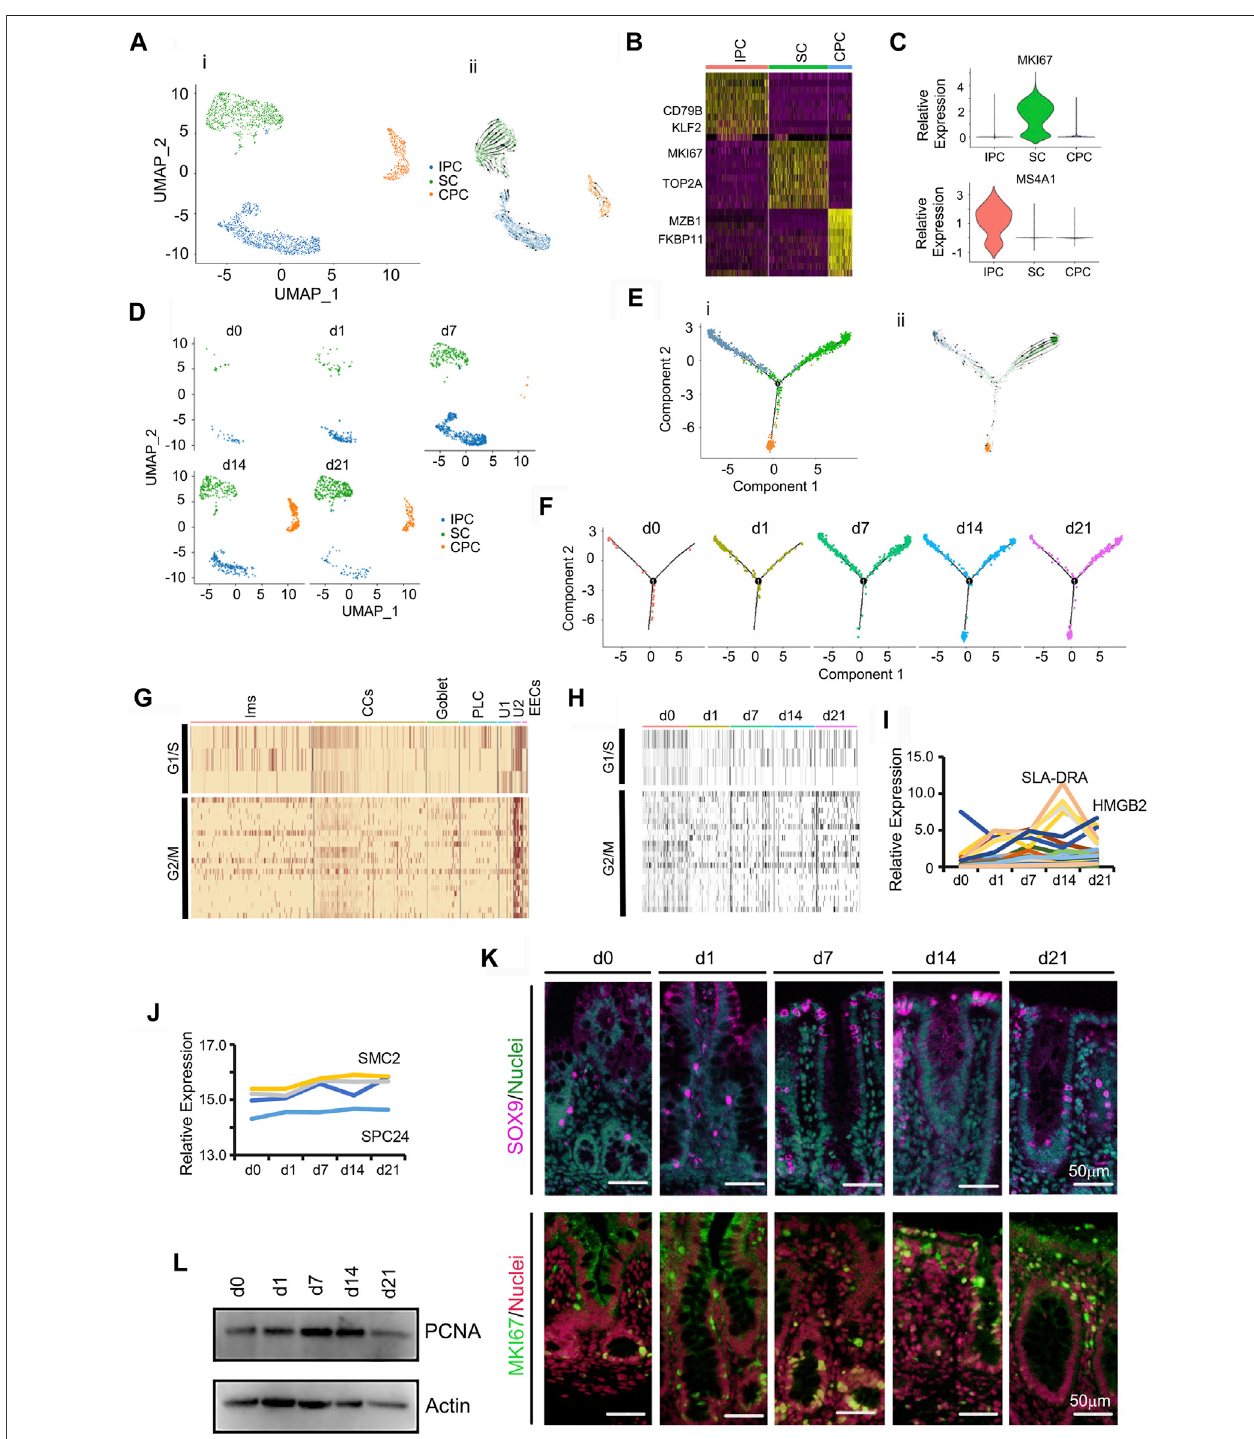
FIGURE 7 | Increase in piglet cecum undifferentiated cells (U1/U2) during the neonatal window. (A) Cell type clusters for U1/U2 for the cells together from the fi ve time points by UMAP. (i) UMAP of undifferentiated single cells (points), colored by cluster assignment. (ii) RNA velocity vector projection on UMAP plots. (B) Heatmap of the top 25 marker genes in each cluster of U1/U2. (C) Expression pattern of marker genes in different clusters of U1/U2. (D) U1/U2 population changes during development (from d0 to d21). (E) Trajectory reconstruction of U1/U2 based on cell clusters according to pseudotime analysis. (i). Monocle plot. (ii). RNA velocity vector projection on a monocle plot (The arrow indicated the developmental trend). (F) Monocle images for different samples at 5 time points. (G) Heatmap of cluster genesforthe cellcycle indifferentclustersofcells. (H) Heatmap ofcluster genesforthe cellcycle in samplesat different time points. (I) The relative expression pattern of